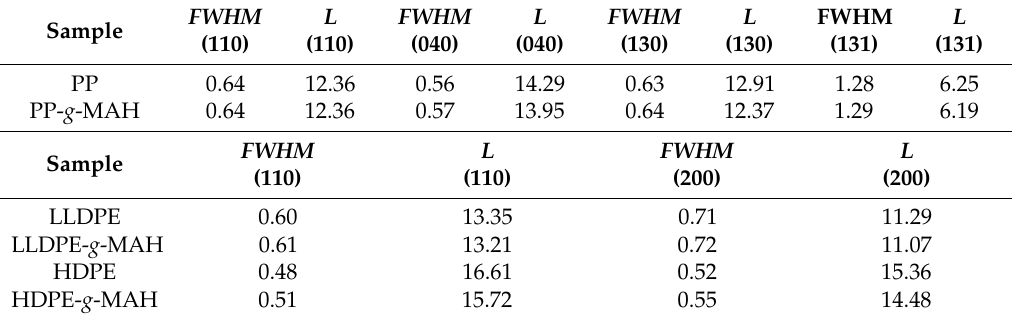
Figure 2. WAXS di ff raction curves of PP and MAH- g -PP ( a ), LLDPE and LLDPE- g -MAH ( b ), HDPE Figure 2. WAXS diffraction curves of PP and MAH- g -PP ( a ), LLDPE and LLDPE- g -MAH ( b ), HDPE and HDPE- g -MAH ( c ). and HDPE- g -MAH ( c ). Table 2. Crystal size ( L / nm) for di ff erent polyolefin samples together with FWHW / o Table 2. Crystal size ( L /nm) for different polyolefin samples together with FWHW/ o